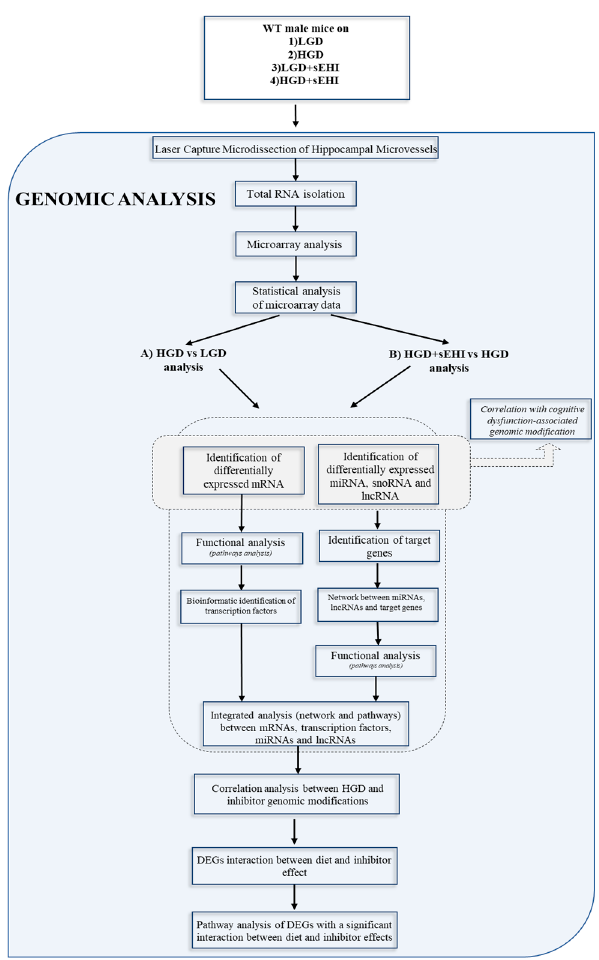
Figure 1. Research methodology flow chart. The flow chart shows the steps in the genomic analysis for: (A) the high glycemic diet compared to the low glycemic diet (HGD vs LGD), and (B) the high glycemic diet with the soluble epoxide hydrolase inhibitor (sEHI) compared to without the sEHI (HGD + sEHI vs HGD).